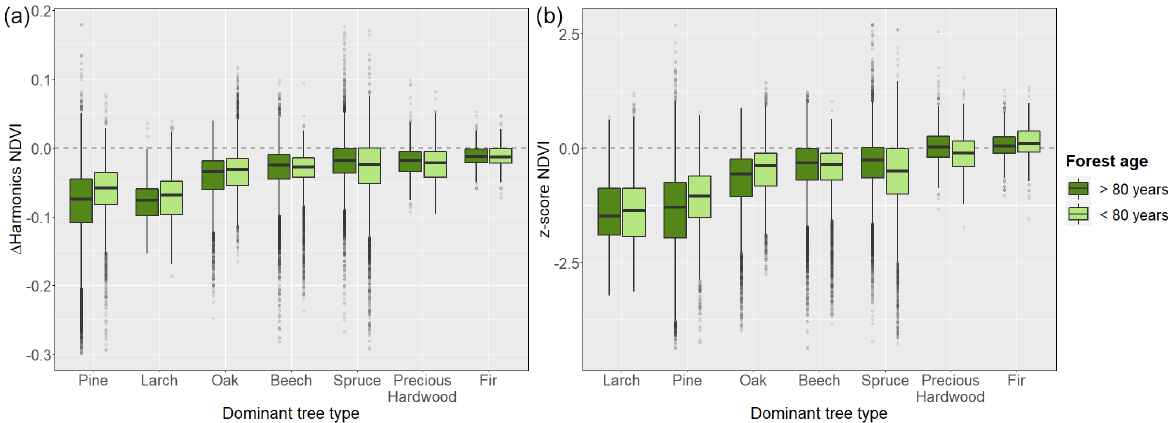
Figure 9. Boxplots of ( a ) 6th degree ∆ Harmonic NDVI and ( b ) z-score NDVI values in August 2018 for forests with different dominant tree species based on Landsat data. Forests with Larch and Pine as the dominant species feature overall lowest values. Tree types are ordered after the overall mean value.